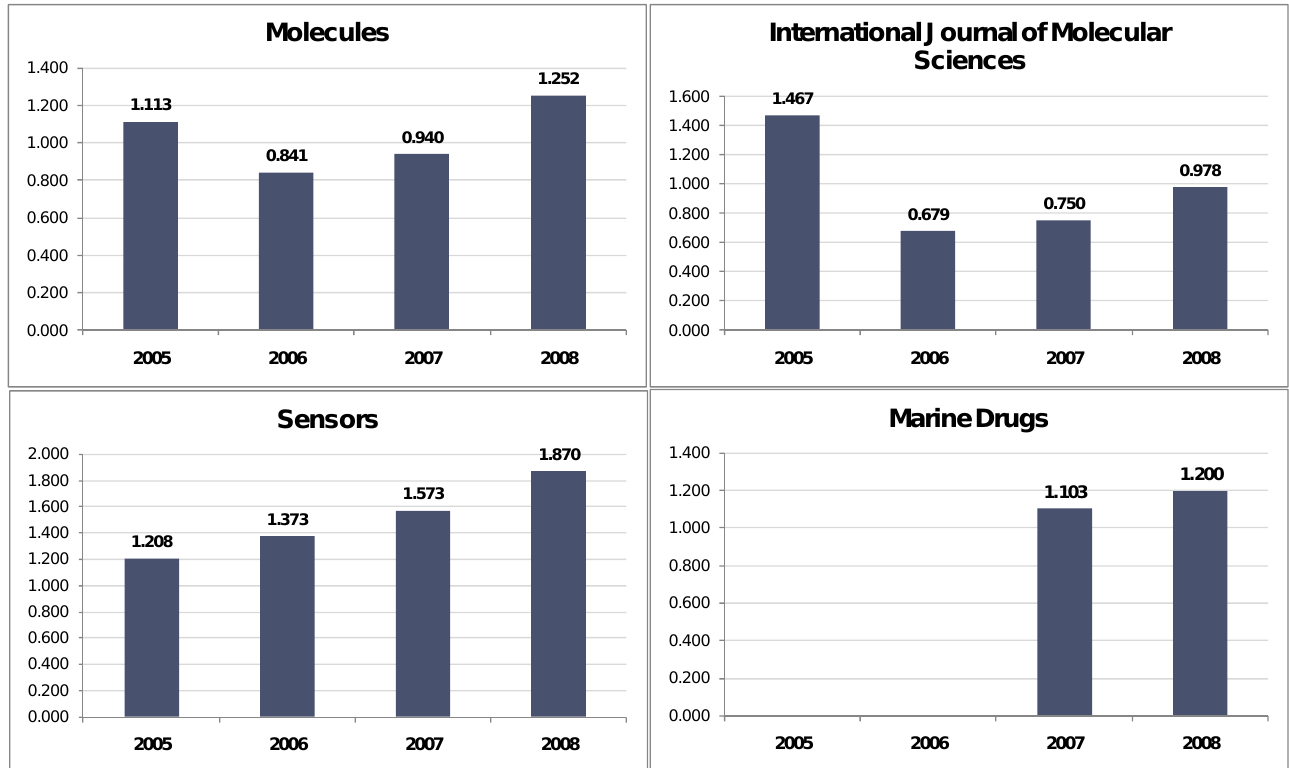
Figure 1. Impact factors of four MDPI journals (adapted from the Journal Citation Report (JCR), Edition 2008, Copyright 2009 by Thomson